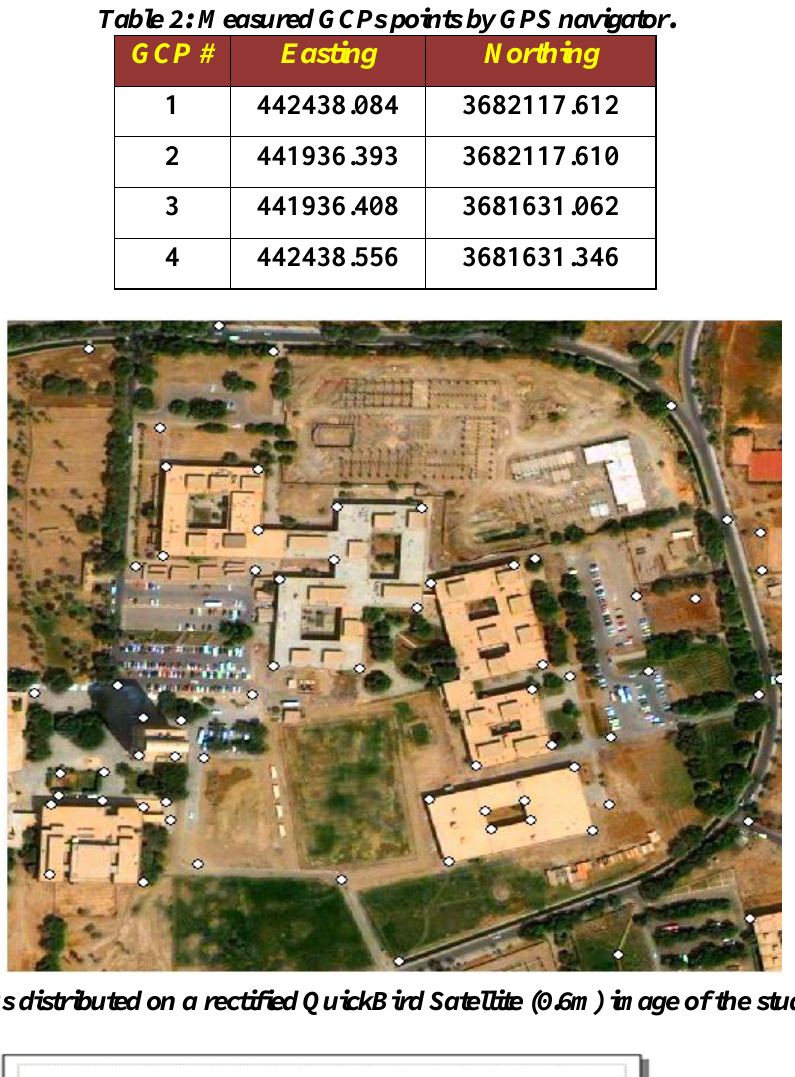
Table 2: Measured GCPs points by GPS navigator.